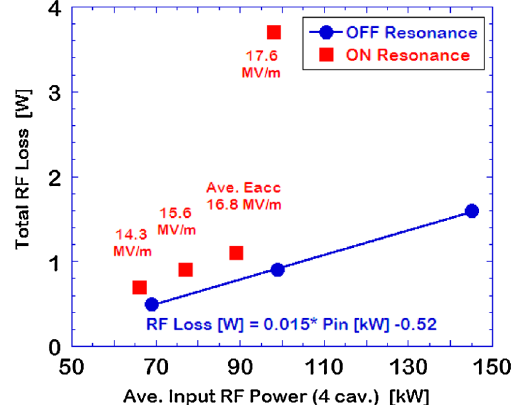
FIG. 26. (Color) Measurement of total dynamic rf losses at 2 K in four-cavity simultaneous operation with off-resonance (blue) and on-resonance (red). The measured static loss of 9 W has already been subtracted in this figure.